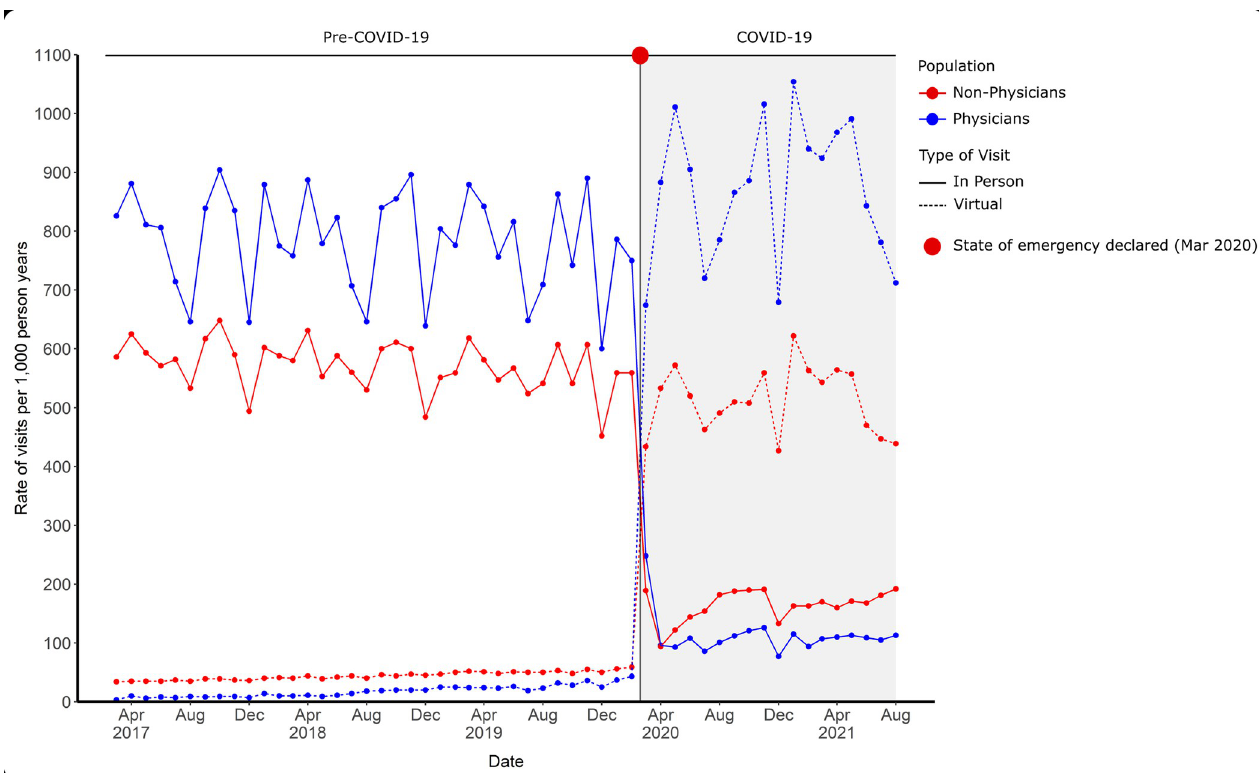
Fig 2. Age and sex standardized monthly rates of virtual and in–person outpatient MHA visits among physicians and non–physicians. COVID–19, Coronavirus Disease 2019; MHA, mental health and addiction.